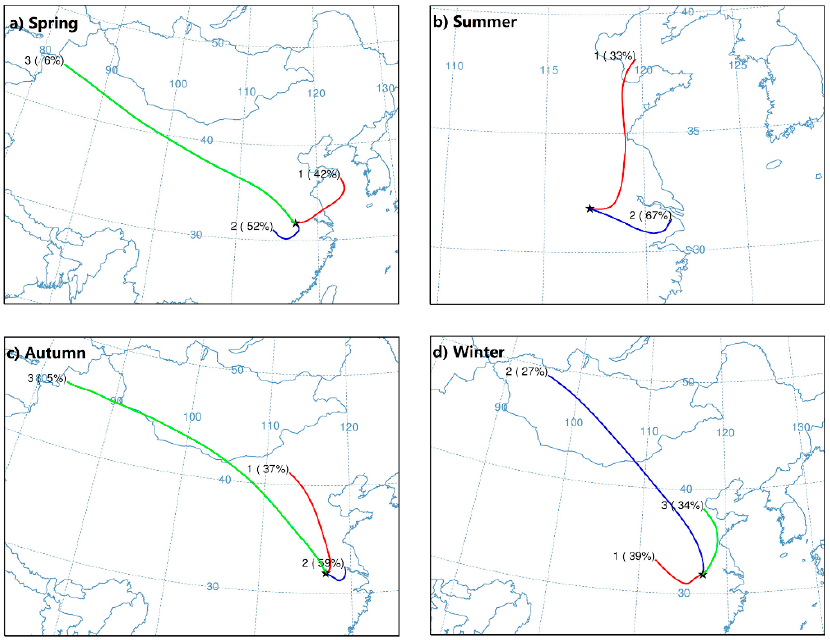
Figure 6. 72 h airmass backward trajectories analysis during episode days (PM 2.5 > 75 µ g / m 3 ) from December 2013 to November 2015.